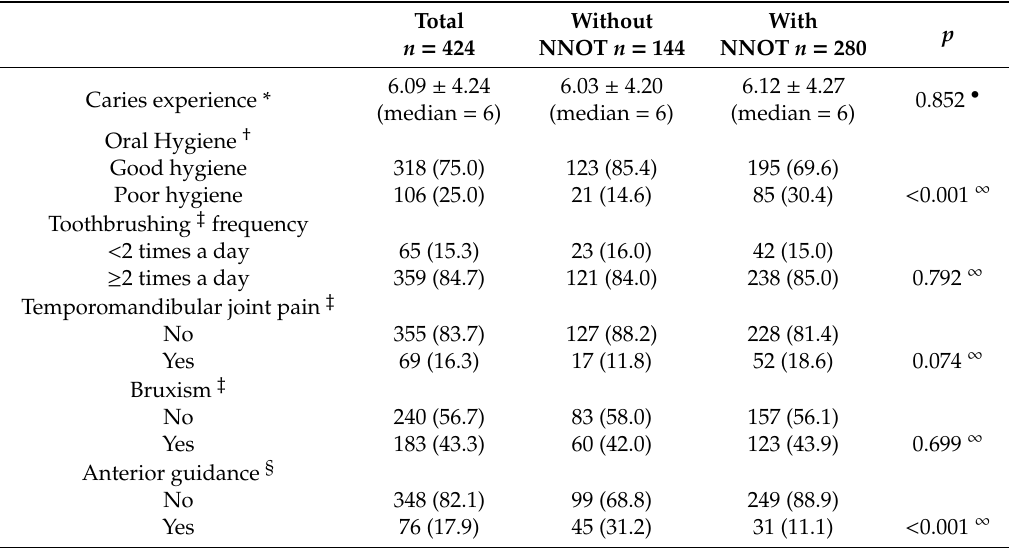
Table 2. Distribution of the oral health indicators by the Normative Need for Orthodontic Treatment (NNOT) prevalence